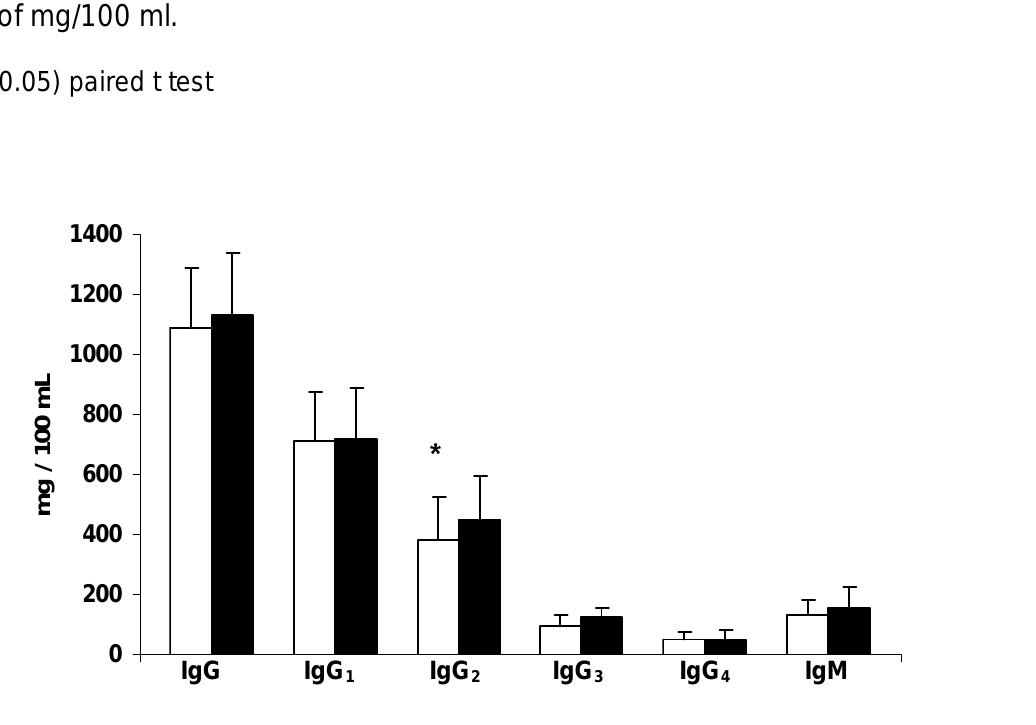
Figure 3: IgG and subclass serum levels in patients evaluated before and after 28 days of treatment with rabies serum vaccination. Results are expressed as mean + SD of mg/100